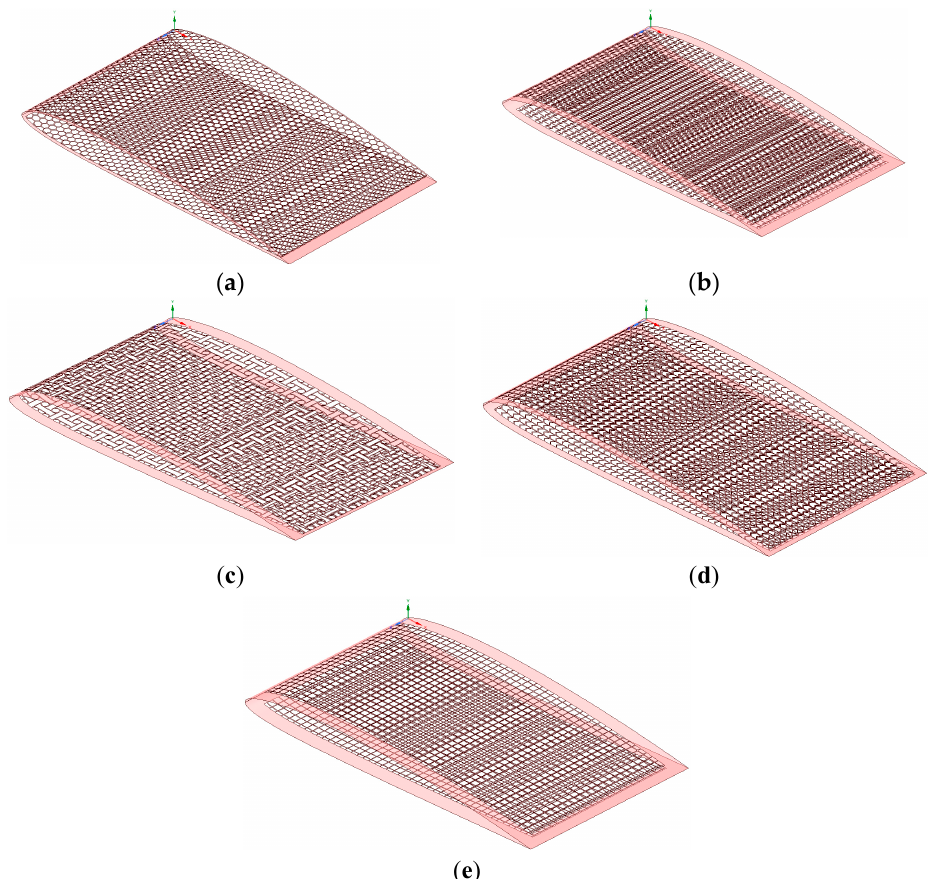
Figure 7. Computational models selected for this study: ( a ) honeycomb, ( b ) auxetic, ( c ) chiral, ( d ) zero Poisson’s ratio honeycomb, and ( e ) square lattices.